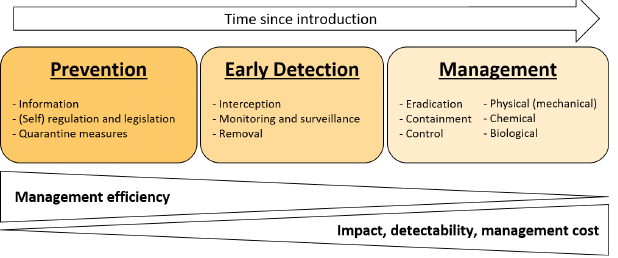
Fig. 1 . Management strategies for invasion management. (Source: Modified Figure 1 from Simberloff et al.